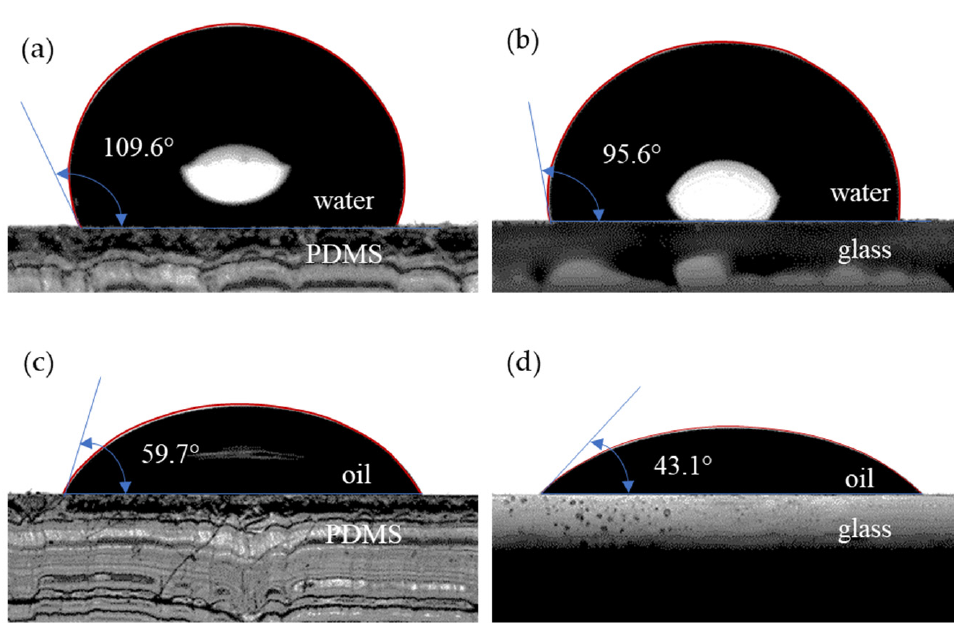
Figure 3. Contact angle: ( a ) water–PDMS; ( b ) water–glass; ( c ) oil–PDMS; ( d ) oil–glass.